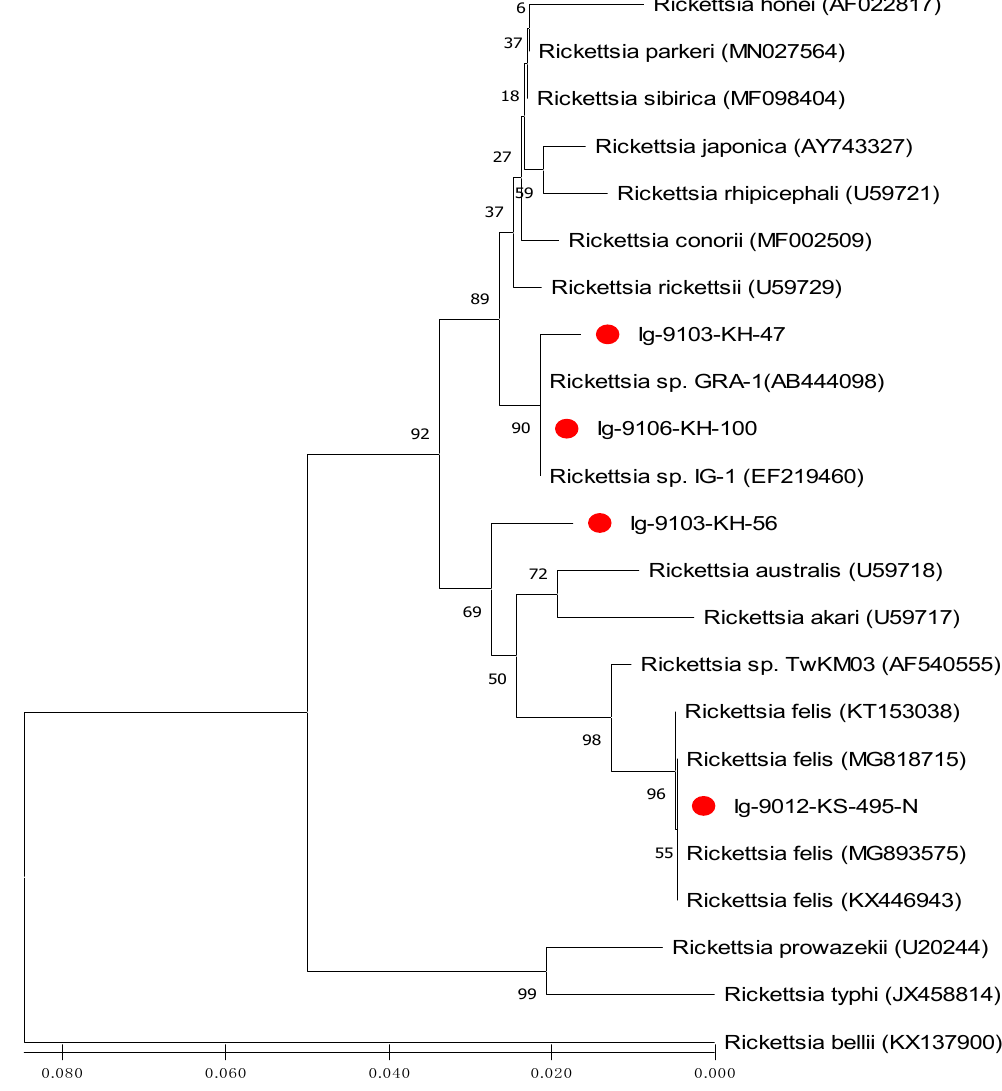
Figure 2. Phylogenetic relationships based on the citrate synthase gene ( gltA ) sequences of Rickettsia between 4 specimens (indicated as • ) collected from Ixodes granulatus ticks of Kinmen Island and 19 other Rickettsia specimens identified from various biological and geographical origins. The tree was constructed and analyzed by neighbour-joining (NJ) method using 1000 bootstraps replicates. Numbers at the nodes indicate the percentages of reliability of each branch of the tree. Branch length is drawn proportional to the estimated sequence divergence.